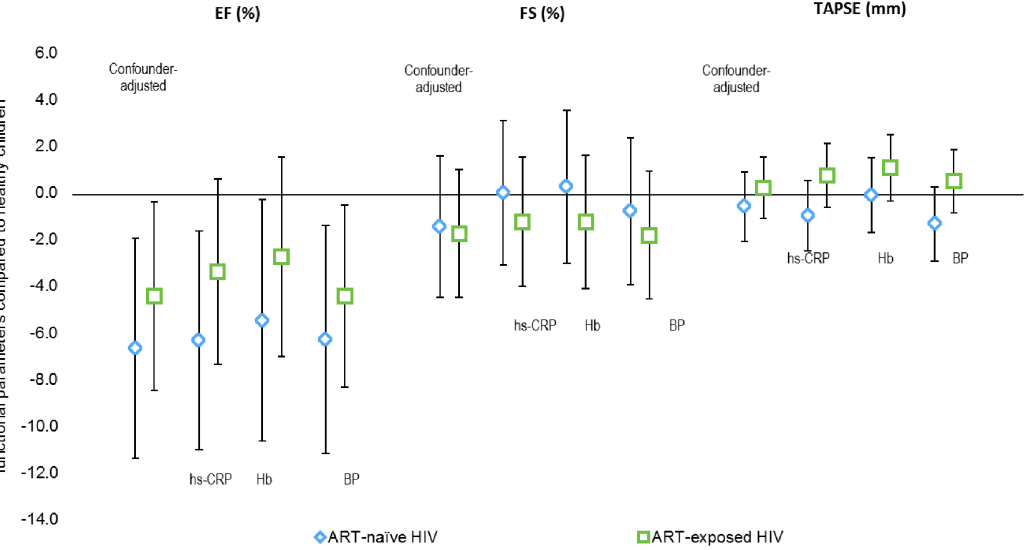
Fig 2. Influence of potential explanatory variables on cardiac functional estimates in ART-naive and ART-exposed HIV infected children. Note: EF = ejection fraction; FS = fractional shortening; TAPSE = tricuspid annular plane systolic excursion; Hb = hemoglobin level; BP = systolic and diastolic blood